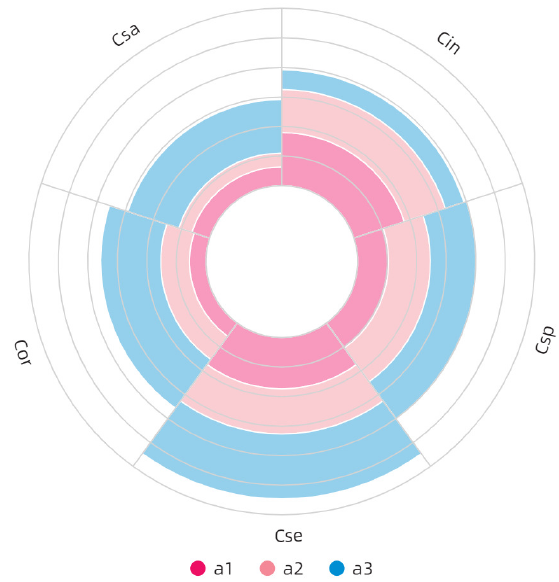
Figure 4. The analysis of the venues under the first-level